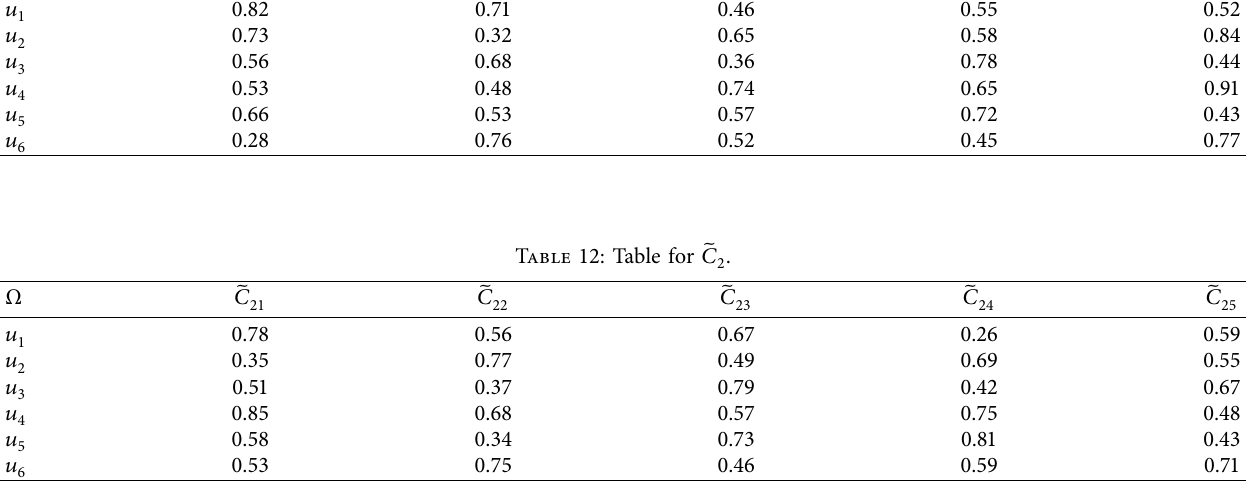
Table 11: Table for 􏽥 C